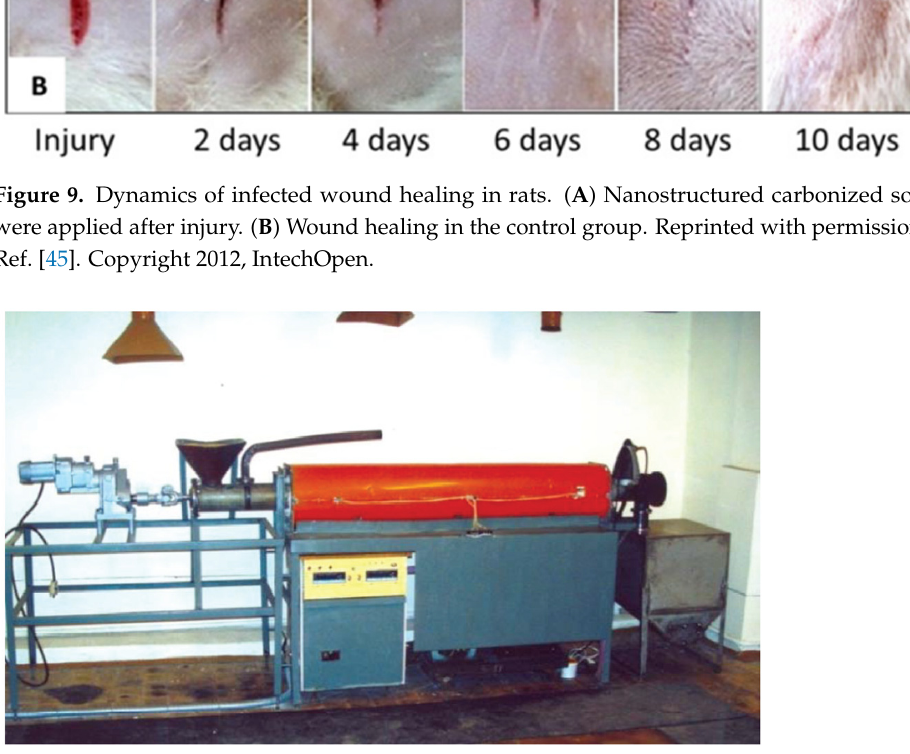
Figure 9. Dynamics of infected wound healing in rats. ( A ) Nanostructured carbonized sorbents were applied after injury. ( B ) Wound healing in the control group. Reprinted with permission from Ref. [45]. Copyright 2012, IntechOpen .